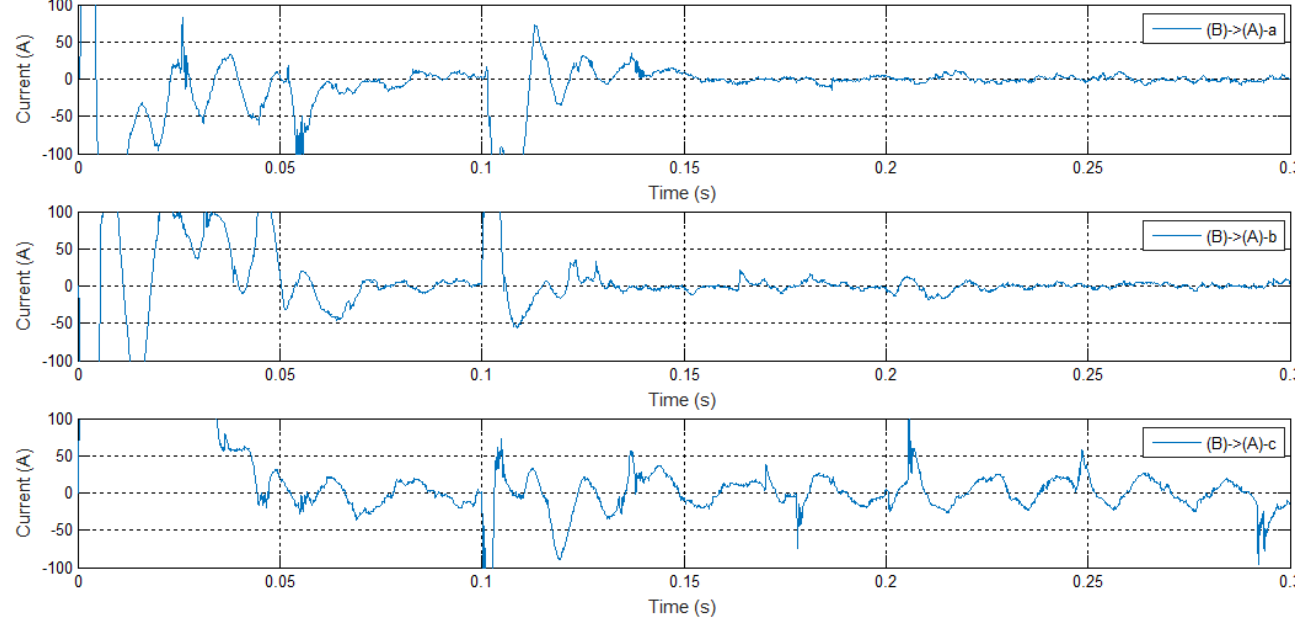
Figure 13. Current exchange per phase between microgrid (A) and microgrid